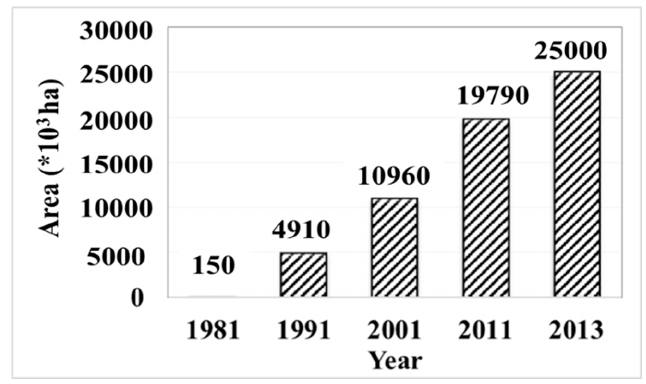
Figure 1. The statistical results of plastic-mulched farmland (PMF) coverage in China.